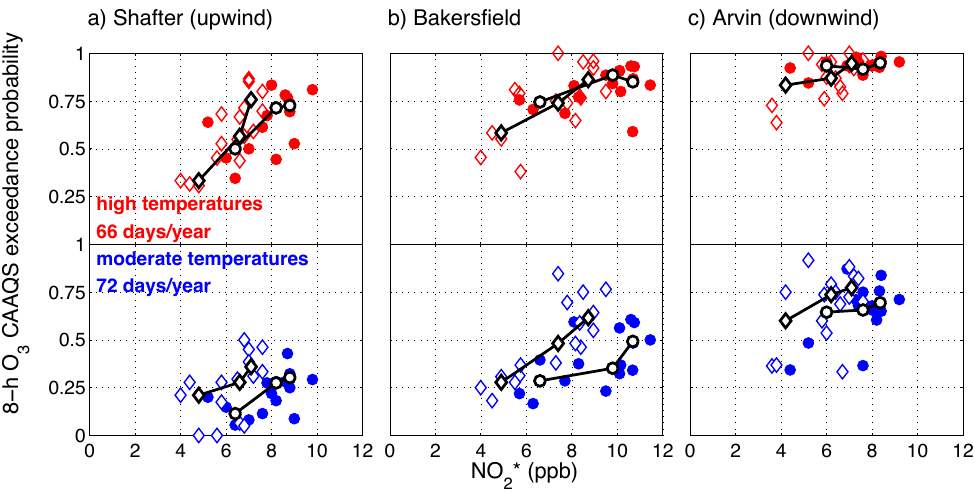
Fig. 4. Southern SJV, Shafter (a) , Bakersfield (b) , and Arvin (c) , exceedance probabilities vs. NO 2 * at high (34–45 ◦ C) and moderate (28– 33 ◦ C) temperatures in red and blue, respectively. Data from weekdays (closed circles) and weekends (open diamonds) are shown as separate symbols. NO 2 * are averages (10:00a.m.–02:00p.m. local time) of hourly data at each site. Uncertainties are typically less than ± 0.09 (1 σ) for weekdays and less than ± 0.12 (1 σ) for weekends. NO 2 * data are reported by CARB to be accurate to at least 15%. Black lines connect the median percentage of violations at every 5th NO 2 * data point. Over the past sixteen years, the average annual number of days per year (rounded up) in the Southern SJV with a maximum temperature in the high-temperature range is 66 and the average number in the moderate-temperature range is 72. Fig. 5. Four-year median exceedance probabilities of the 8-h O 3 CAAQS vs. year (increasing right to left) in the Southern SJV: Shafter (a) , Bakersfield (b) , and Arvin (c) . Data are shown for two temperature regimes: high (34–45 ◦ C) and moderate (28–33 ◦ C) in red and blue, respectively and divided into weekdays (closed circles) and weekends (open diamonds). The exceedance probabilities are shown for 1995– 1998, 1999–2002, 2003–2006, and 2007–2010. Error bars are uncertainties in the four-year median exceedance probabilities, are calculated as counting errors, and are typically less than ± 0.04 (1 σ) for weekdays and ± 0.06 (1 σ) for weekends. The average number of days per year over the past sixteen years for both temperature regimes is 66 (high) and 72 (moderate) .